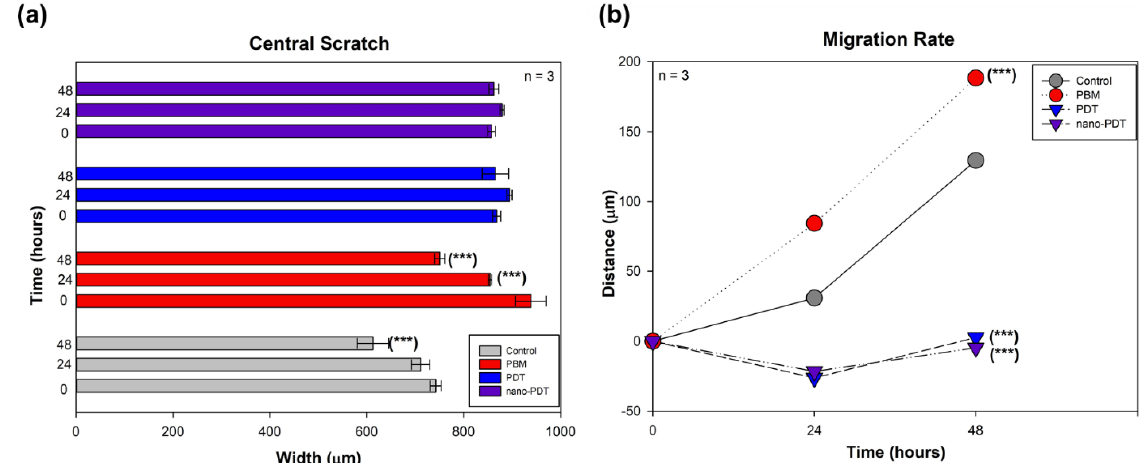
Figure 4. Migration analysis of lung epithelial carcinoma cells (A549) at 0, 24, and 48 h post-PDT treatment: ( a ) Central scratch width of experimental samples over time. ( b ) Migration rate indicating the distance (µm) the cells travelled over time.